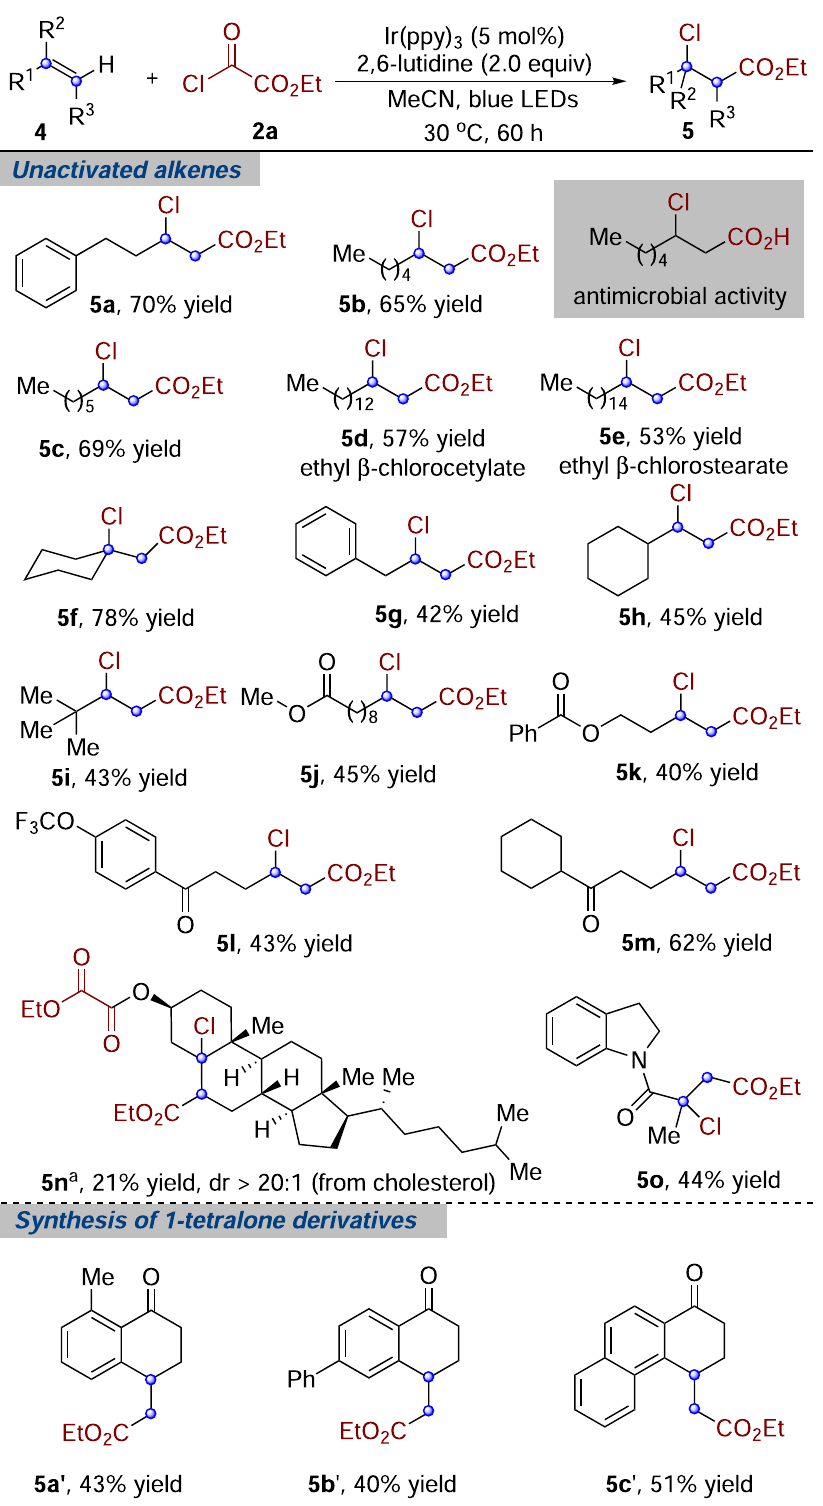
Fig. 3 Alkoxycarbonylchlorination with unactivated alkenes. Reaction conditions: unactivated alkene 4 (0.2 mmol), ethyl chlorooxoacetate 2a (1.6 mmol), Ir(ppy) 3 (5 mol %), 2,6-lutidine (0.4 mmol), anhydrous MeCN (4.0 mL), blue LEDs, 30 °C, 60 h, under N 2 atmosphere. Isolated yields. a Reaction time: 84 h. The dr value was determined by 1 H NMR